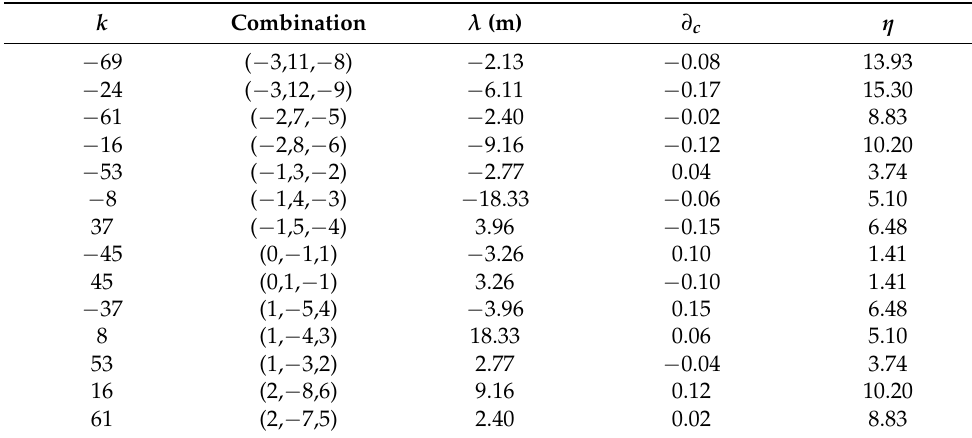
Figure 5. Partial enlarged drawing of the origin area in S 0 . Table 4. Information of all combinations in Figure